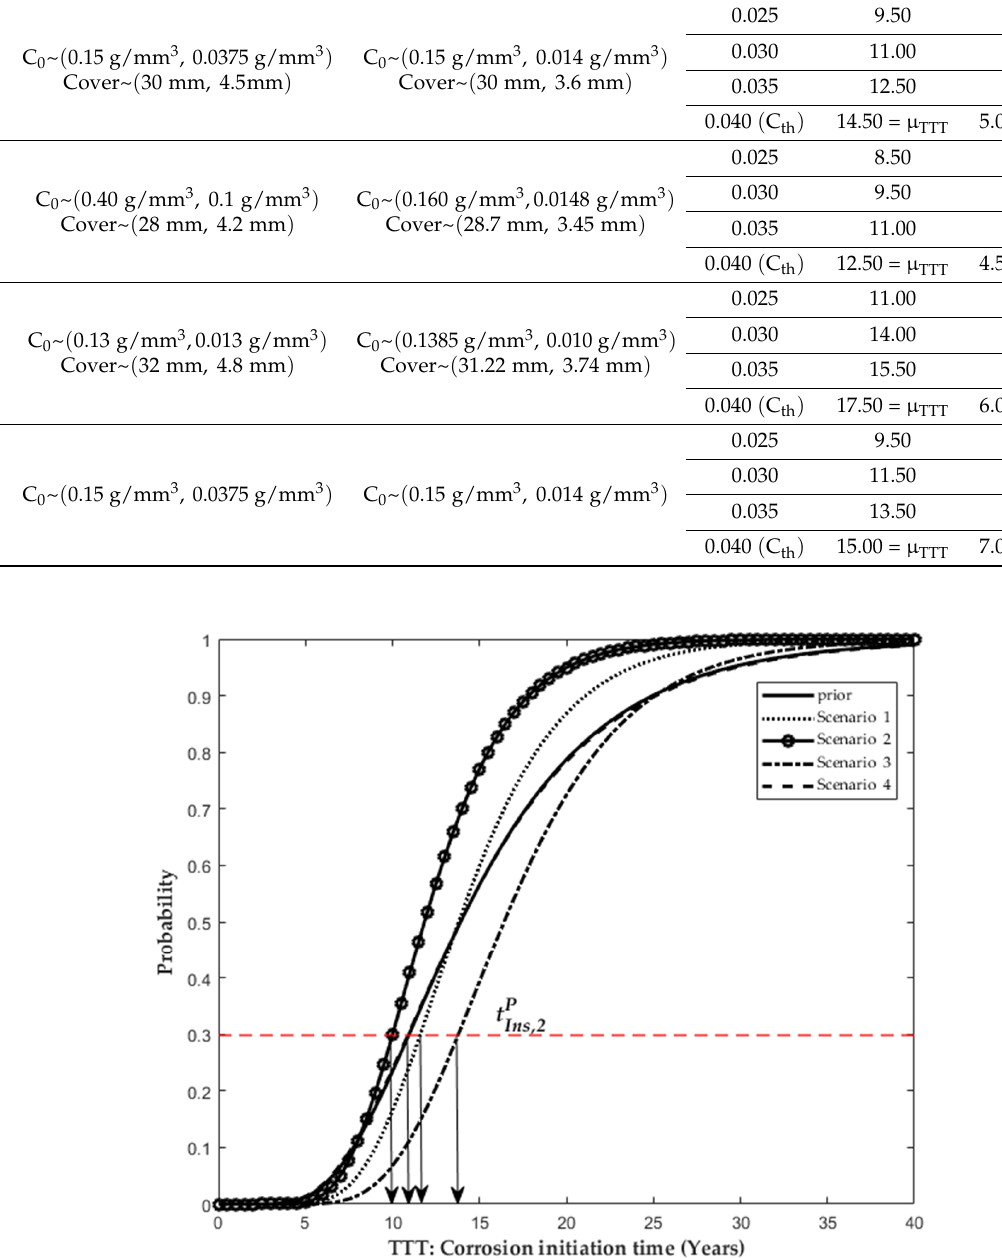
Figure 6. Cumulative probability of failure lifetime function F(t) based on inspection scenario.